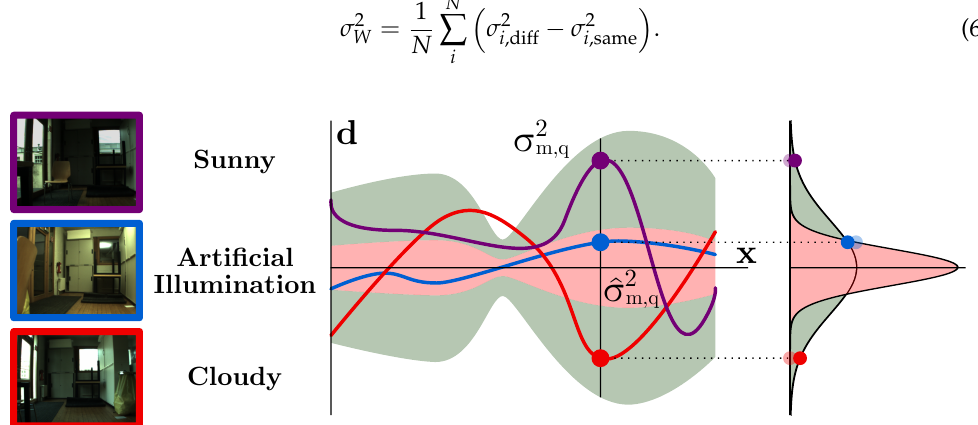
Figure 3. These three images have been captured at the same pose but with different appearances. Ideally, their descriptors (blue, red, and purple dots) should be identical but, in practice, certain inaccuracies appear. As the GP learns the descriptor distribution uniquely from the appearance of the map, this variation is not considered, leading to an underestimated GP uncertainty (red area, ˆ σ 2 m , q ). The inclusion of white noise expands such uncertainty (green area, σ 2 m , q ), solving this